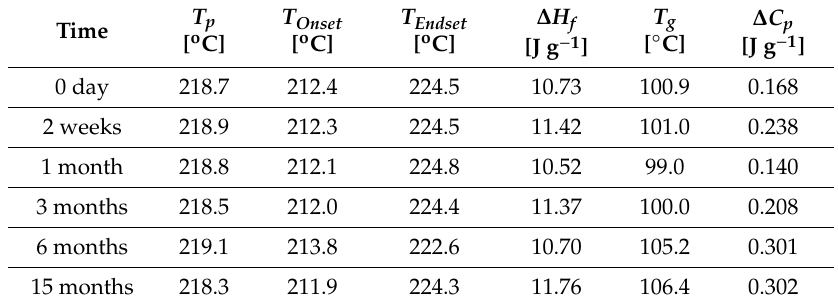
Table 1. Differential scanning calorimetry (DSC) parameters of amorphous imatinib Table 1. Di ff erential scanning calorimetry (DSC) parameters of amorphous imatinib mesylate (IM). mesylate (IM). T p Time